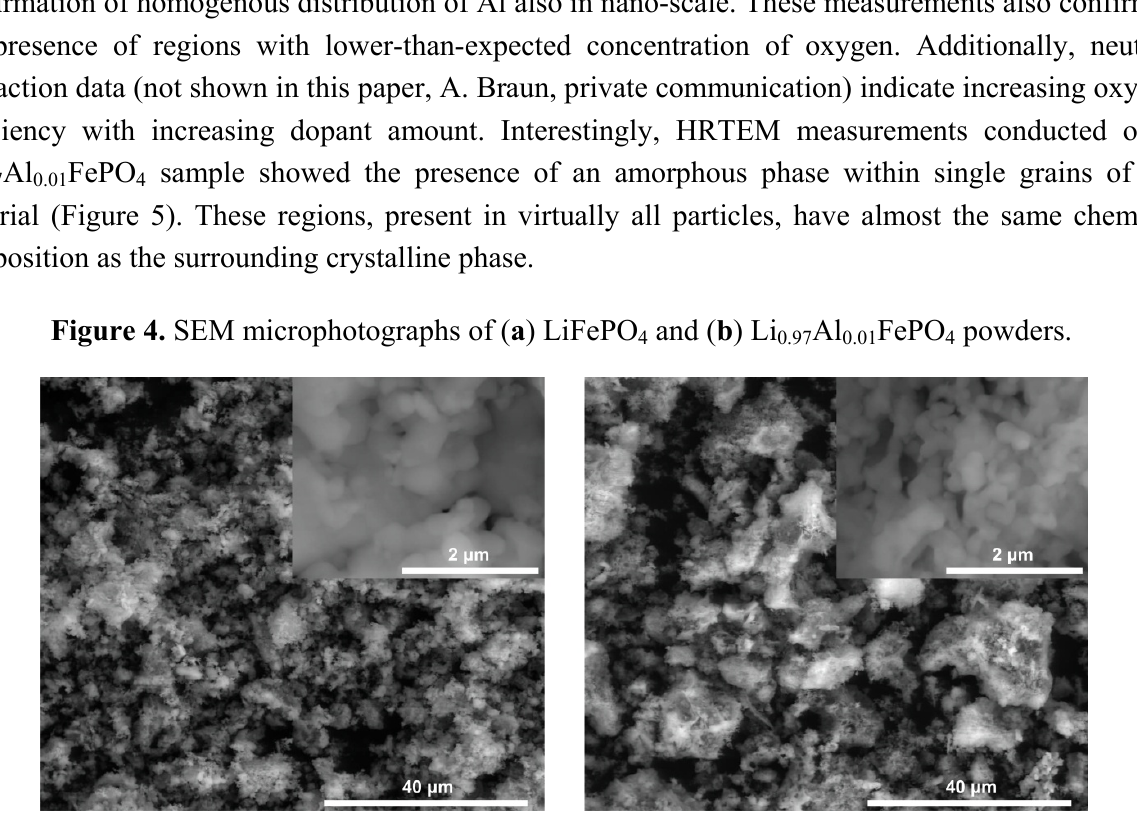
Figure 4. SEM microphotographs of ( a ) LiFePO